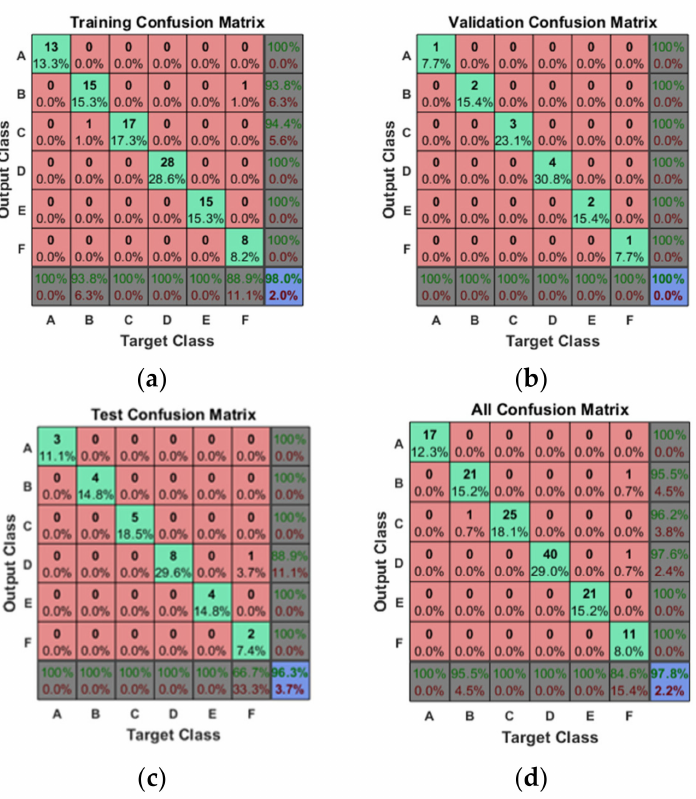
Figure 18. The confusion matrices of ANN trained with SD feature set: ( a ) training confusion matrix, ( b ) validation confusion matrix, ( c ) testing confusion matrix, and ( d ) overall confusion